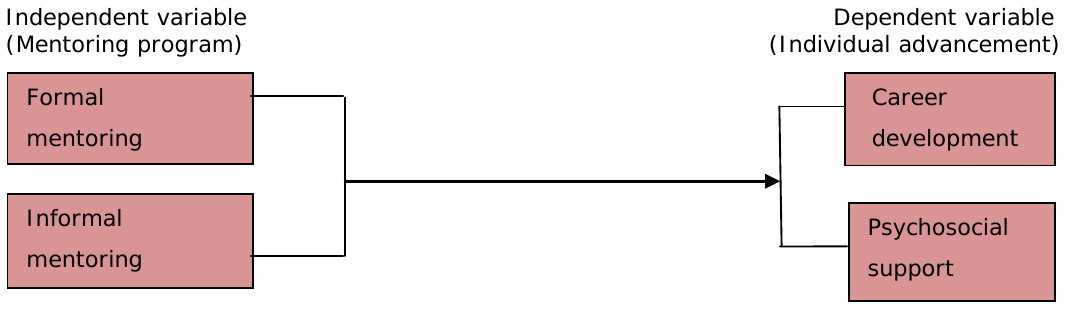
Figure 1. “Conceptual model of the relationship between mentoring programs and individuals’ advancement”. Source: